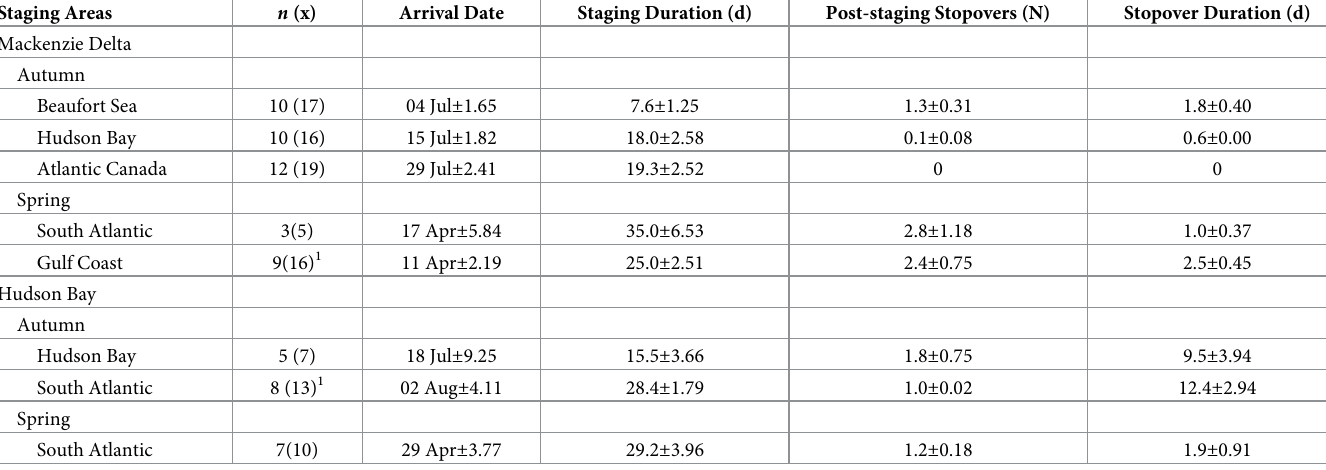
Sample sizes represent number of individuals (total number of seasons) on which values were based. Values represent means ± SE. Stopovers reflect events